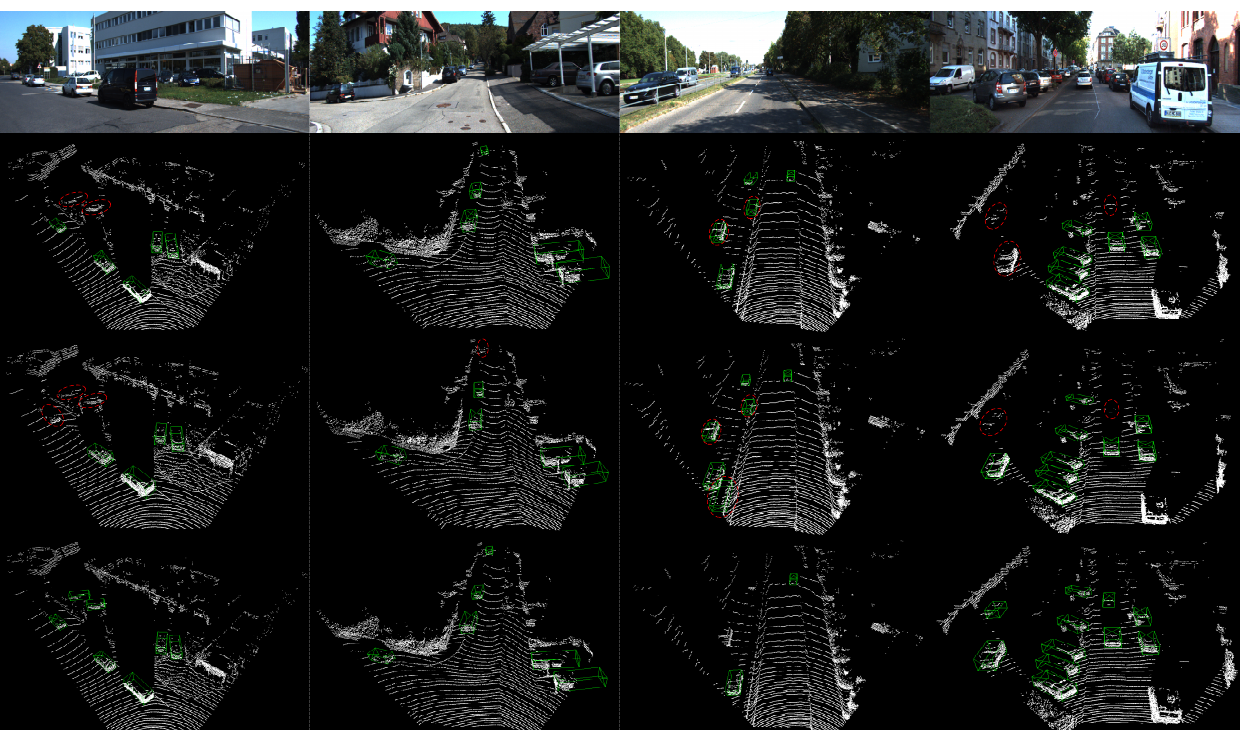
Figure 7. Visual comparisons with two baseline methods. The second row shows the detection results of the modified PointRCNN, the third row shows Part- A 2 and the fourth row shows ours. The detection results of the first, second, and four scenes show our method can detect distant objects than these LiDAR-only methods under the same point cloud input. From the detection results of the third scene, for the van which is very close to the car structure, PTA-Det can effectively reduce false positive instances due to the addition of image semantic